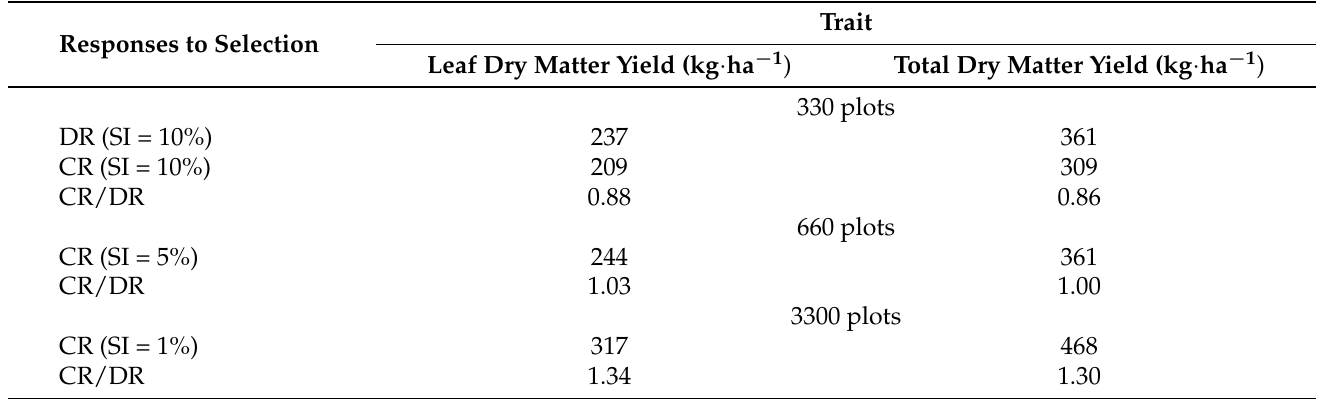
Table 7. Direct (DR) and correlated (CR) response to selection for dry matter traits in the guineagrass breeding program using field and data estimated by the ResNeXt50 pretrained CNN architecture. SI—selection intensity. Responses to